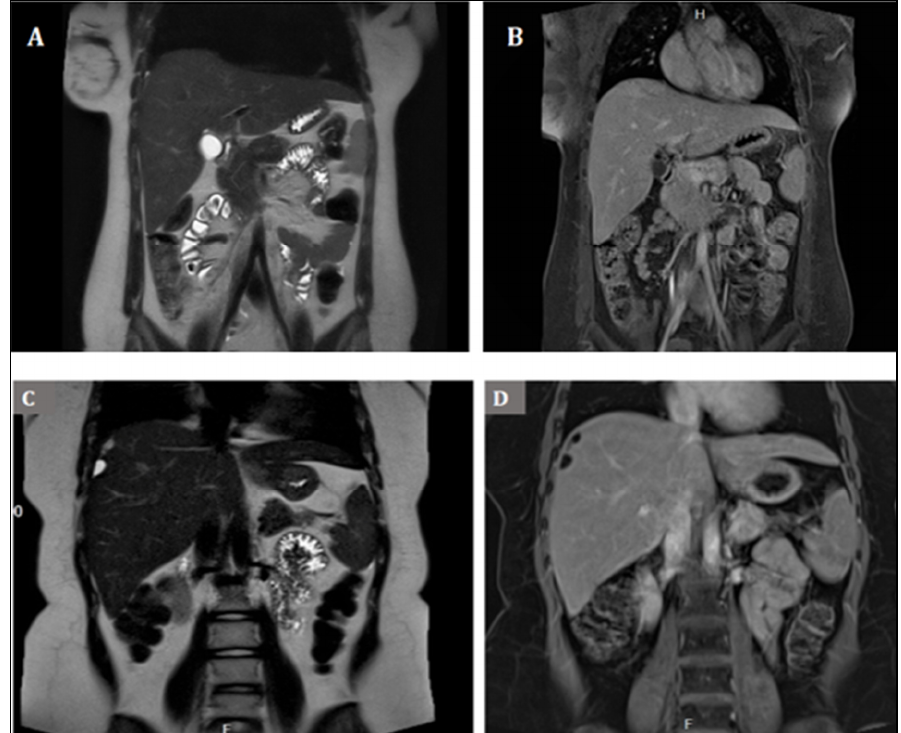
Figure 3. Coronal MRI of the abdominal cavities. ( A ). MRI T2-weighted performed after the surgical procedure, immediately before the start of chemotherapy. ( B ). Contrast-enhanced T1-weighted sequence in the same examination. ( C ). MRI T2-weighted of the abdominal cavity 18 months after completion of chemotherapy shows hyperintense perihepatic and subdiaphragmatic masses. ( D ). T1-weighted fat-suppressed (Dixon) sequence revealed the masses to display low intensity, identifying the small tumors as fat structures rather than liquid containing possible lipomas, an assumption later confirmed after surgical excision.